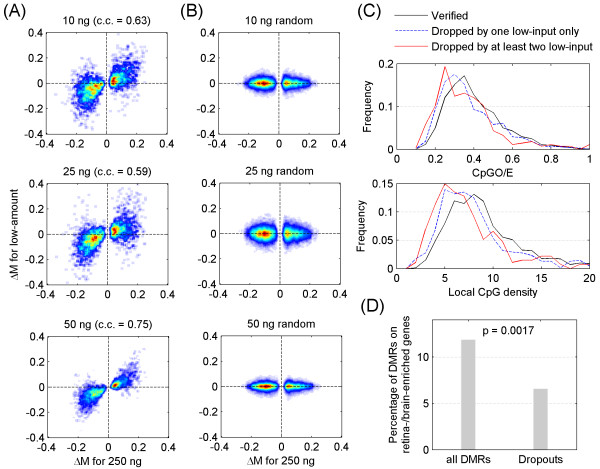
Comparison of T-DMRs from high- and low-input samples identified using MeKL-chip. (A) Correlation of differential methylation between retina and brain (ΔM) from high- and low-input arrays at T-DMRs initially identified within the 250-ng samples. (B) Relationship between ΔM of T-DMRs for high-input and that of randomly shuffled probes for the 10, 25 and 50 ng low-input arrays. (C) Distribution of CpGO/E (top panel) and CpG density (bottom panel) of verified T-DMRs for all three low-input arrays, dropouts from only one low-input array, and dropouts from at least two low-input arrays. (D) Percentage of T-DMRs and dropouts from at least two low-input arrays that were associated with retina-/brain-enriched genes identified from previously published exon array data. c.c: correlation coefficient; CpGO/E: observed-to-expected CpG ratio; MeKL: MBD2b/MBD3L1 enrichment of DNA followed by KLM-PCR; T-DMR: tissue-specific differentially methylated region.